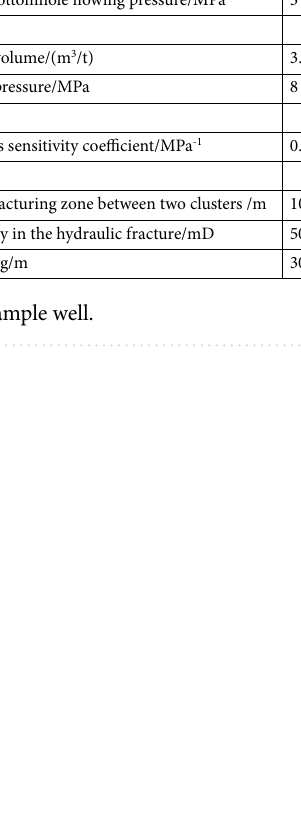
Figure 22. Diagram of daily gas production and time under different pressure control durations.